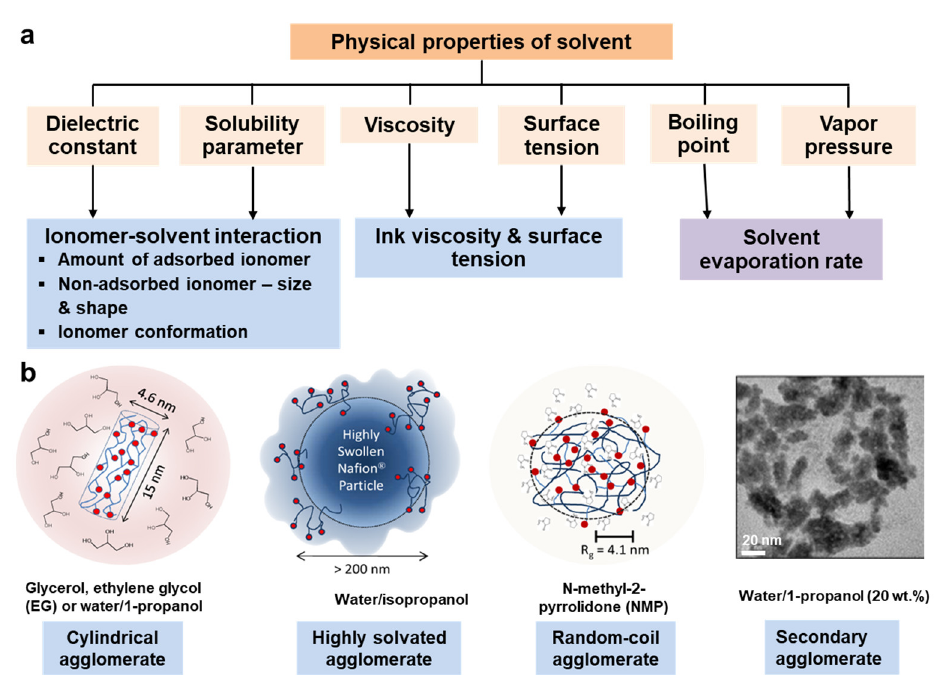
Figure 8. ( a ) The physical properties of solvent and their effects on the microstructure and macro- scopic properties of catalyst ink, or evaporation rate; ( b ) the size and morphologies of Nafion ionomer in different solvents (Adapted with permission from [128], Copyright (2012) American Chemical Society; Reprinted from [26], Copyright (2013), with permission from Elsevier).